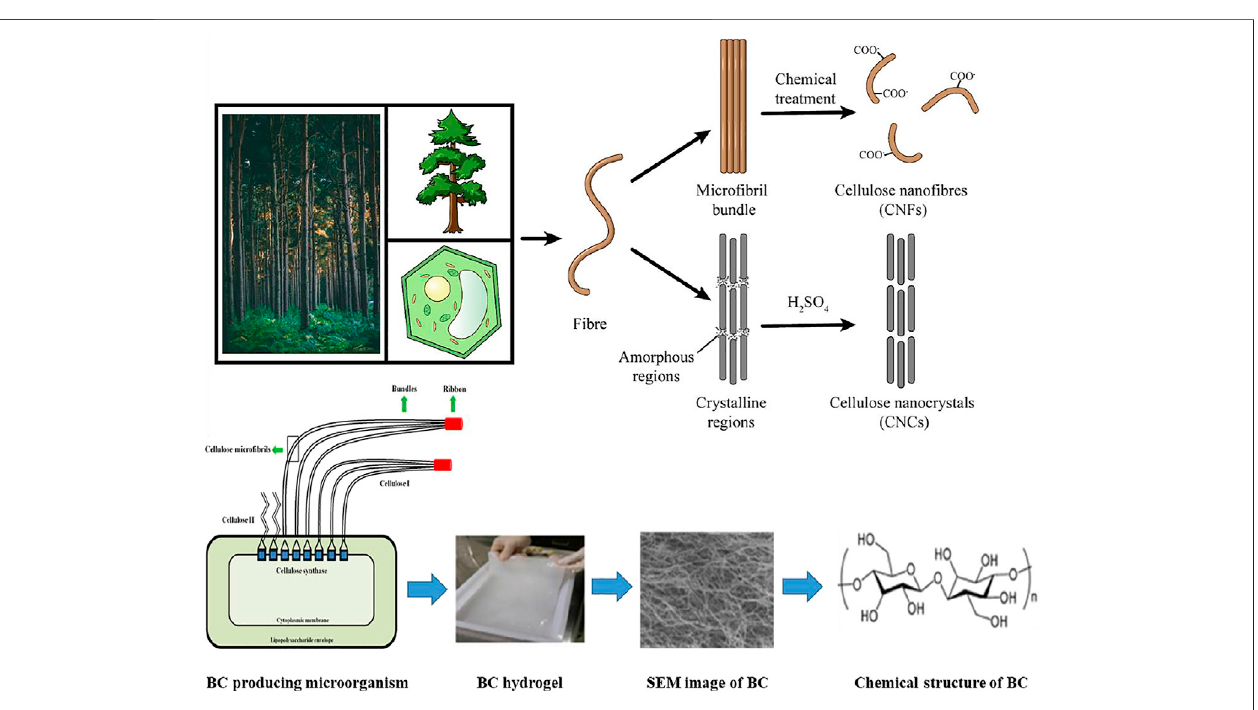
FIGURE 2 | Preparations for three types of